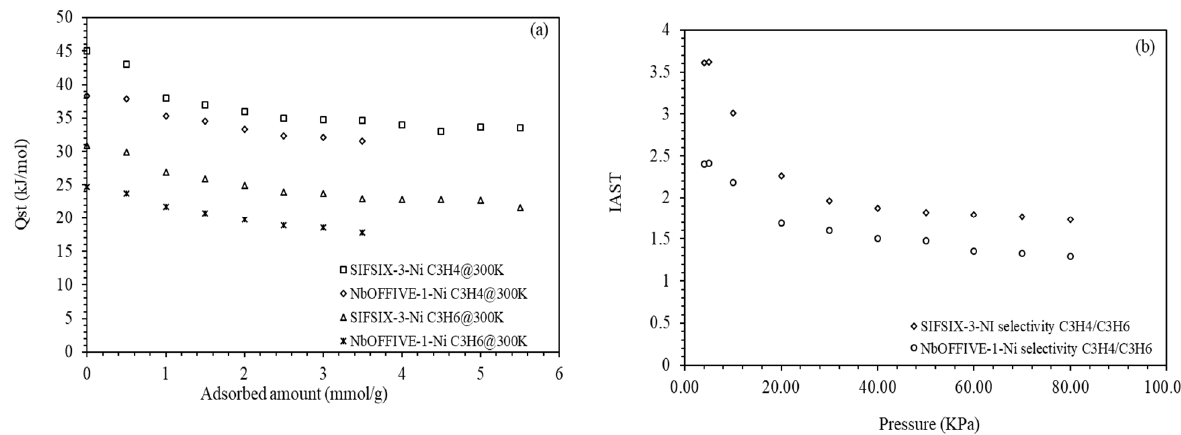
Figure 5. ( a ) Isosteric heats of sorption for SIFSIX and NbOFFIVE metal organic frameworks for both C 3 H 4 and C 3 H 6 as a function of adsorption uptake, ( b ) IAST selectivity for C 3 H 4 /C 3 H 6 system on both adsorbents at 300 K.